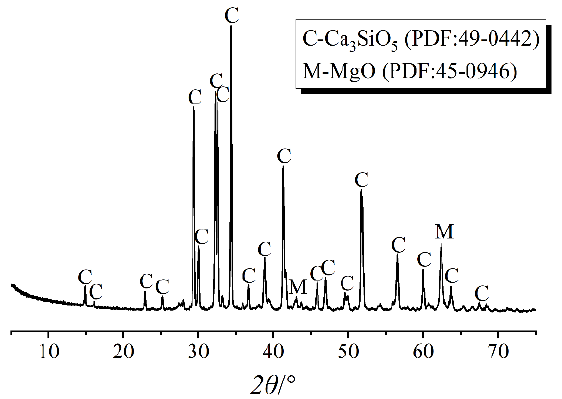
Figure 1. XRD patterns of C 3 S.